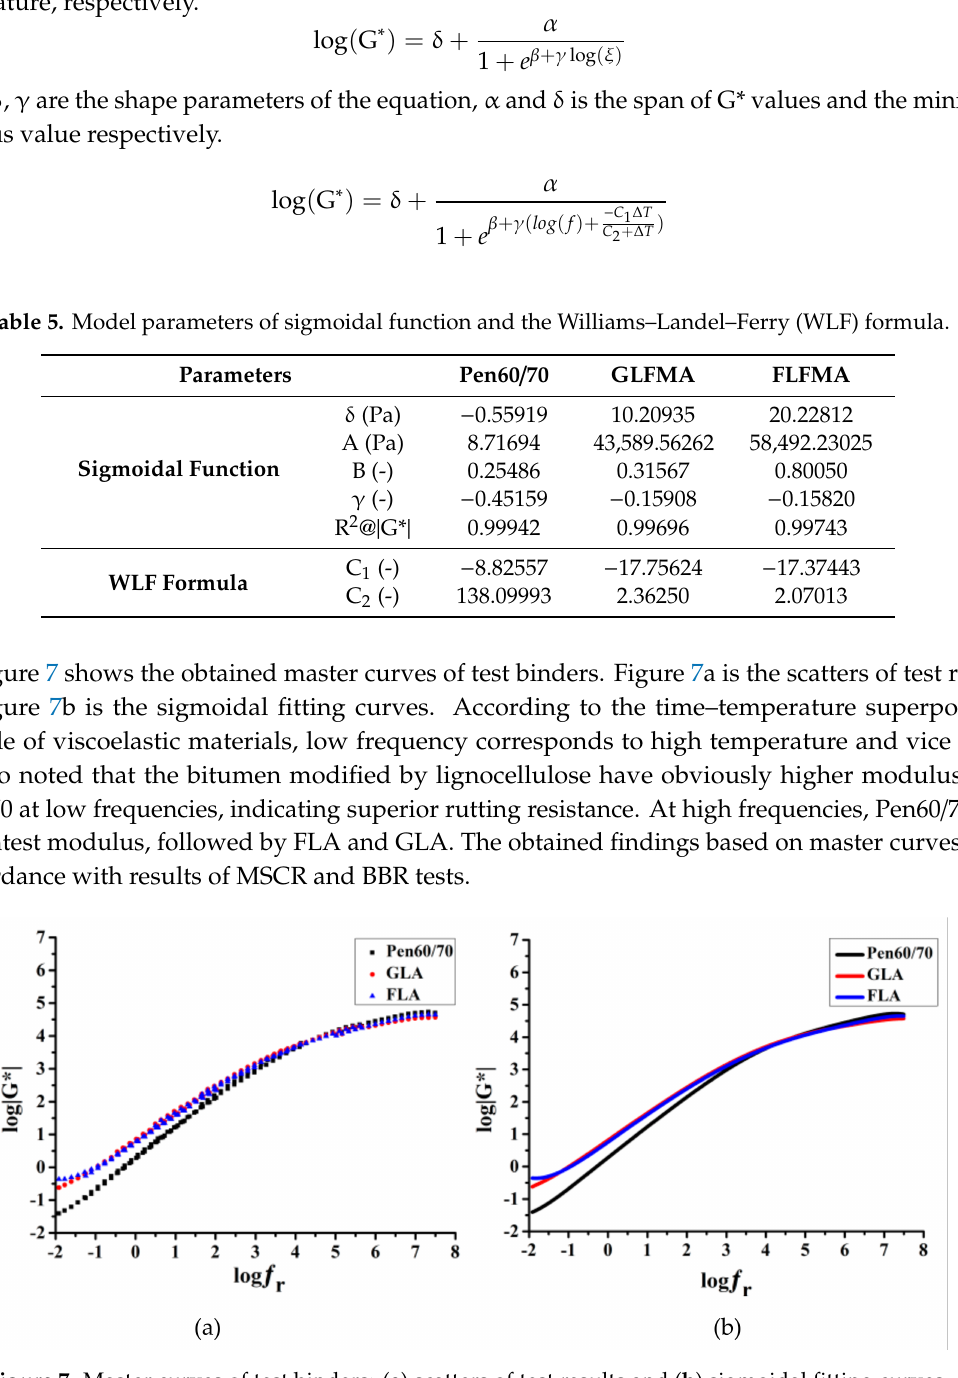
Figure 7. Master curves of test binders: ( a ) scatters of test results and ( b ) sigmoidal fitting